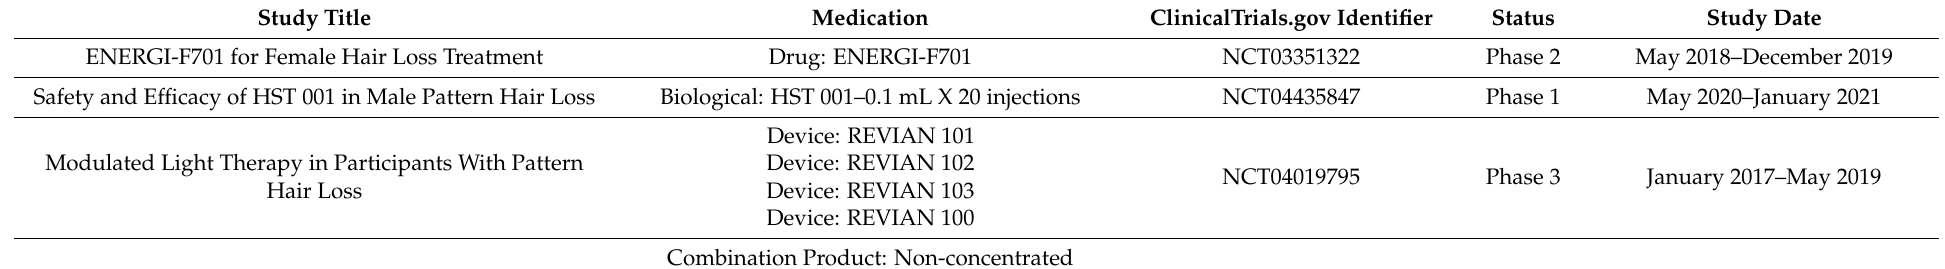
Table 6. Recent clinical trials for hair loss